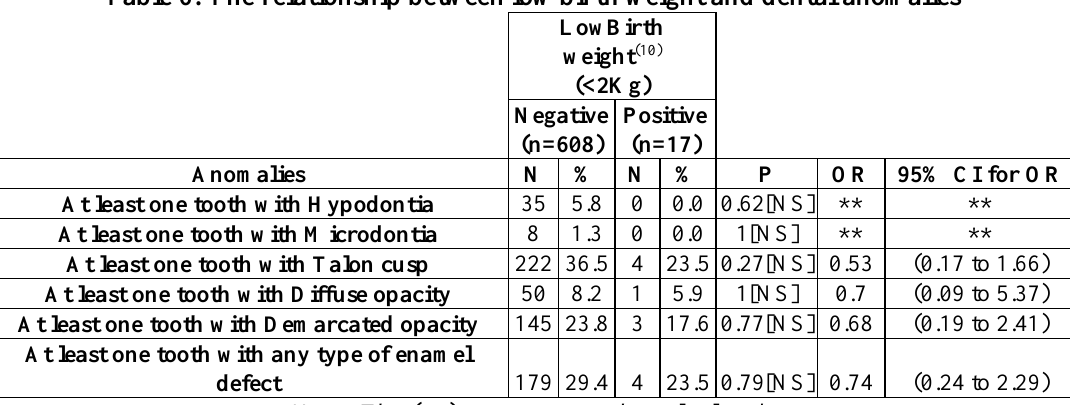
Table 6: The relationship between low birth weight and dental